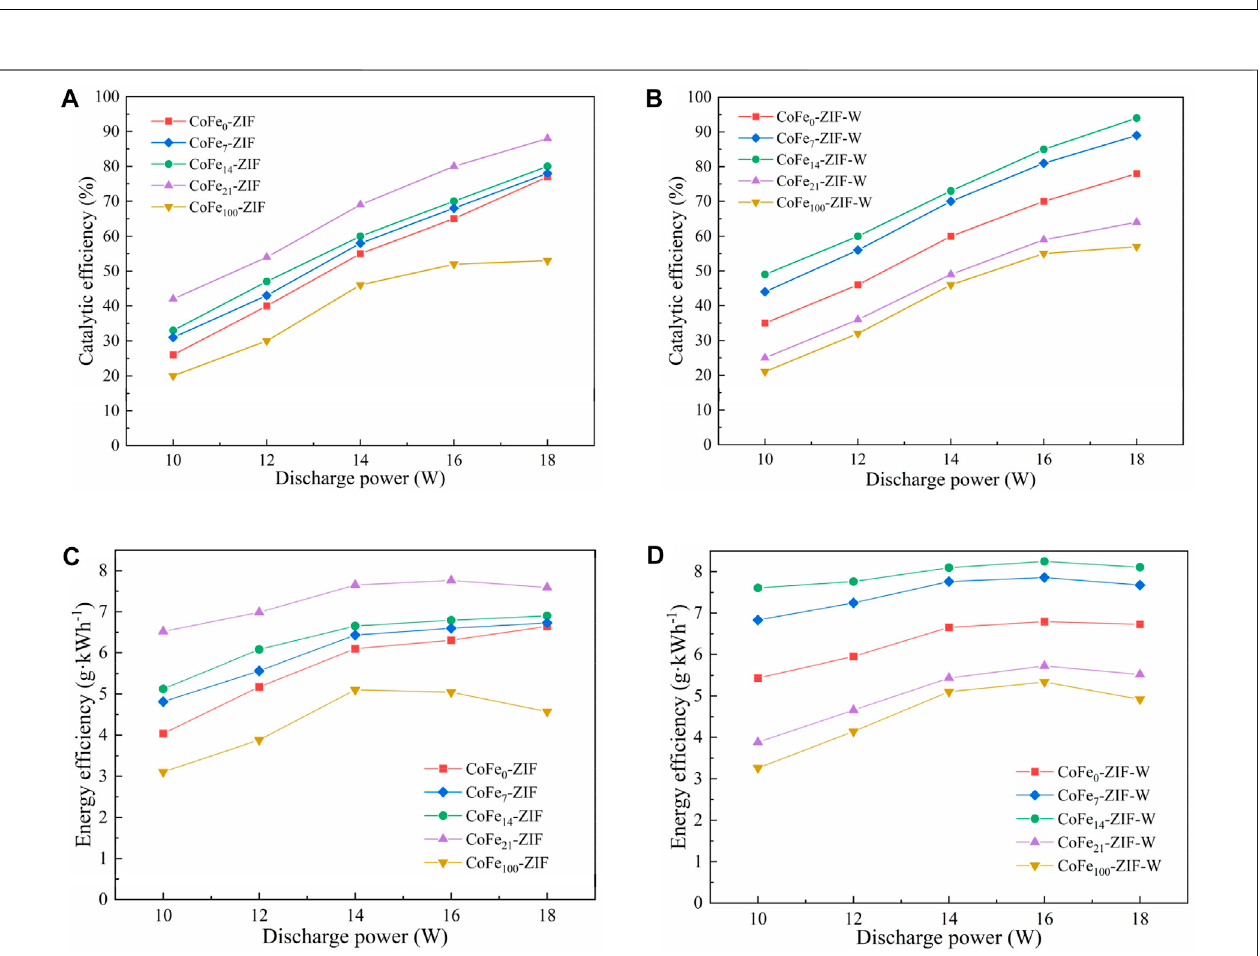
Frontiers in Energy Research |